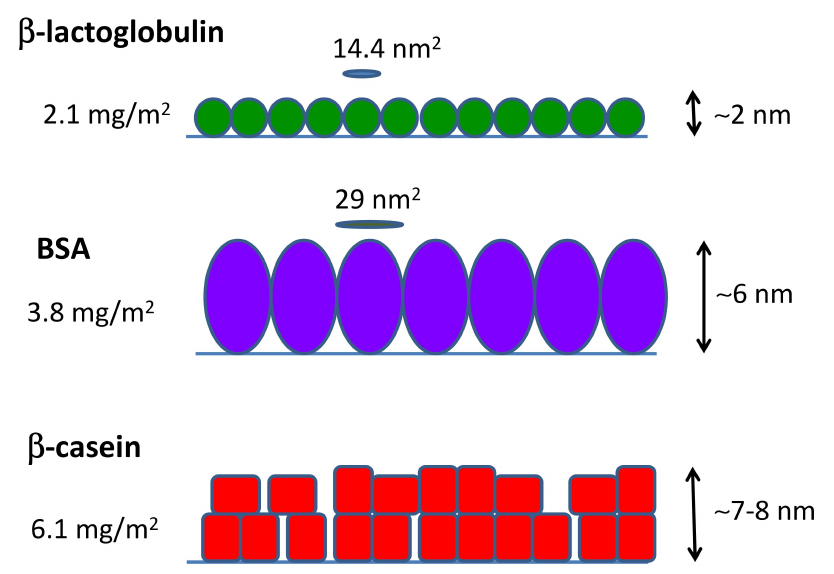
Figure 6. Cartoon indicating the possible arrangement of the different proteins in the protein films, summarizing our results of QCM-D and AFM measurements. The interpretation on which the cartoon is based also takes into account the protein dimensions and shape obtained from simulations (see the text for